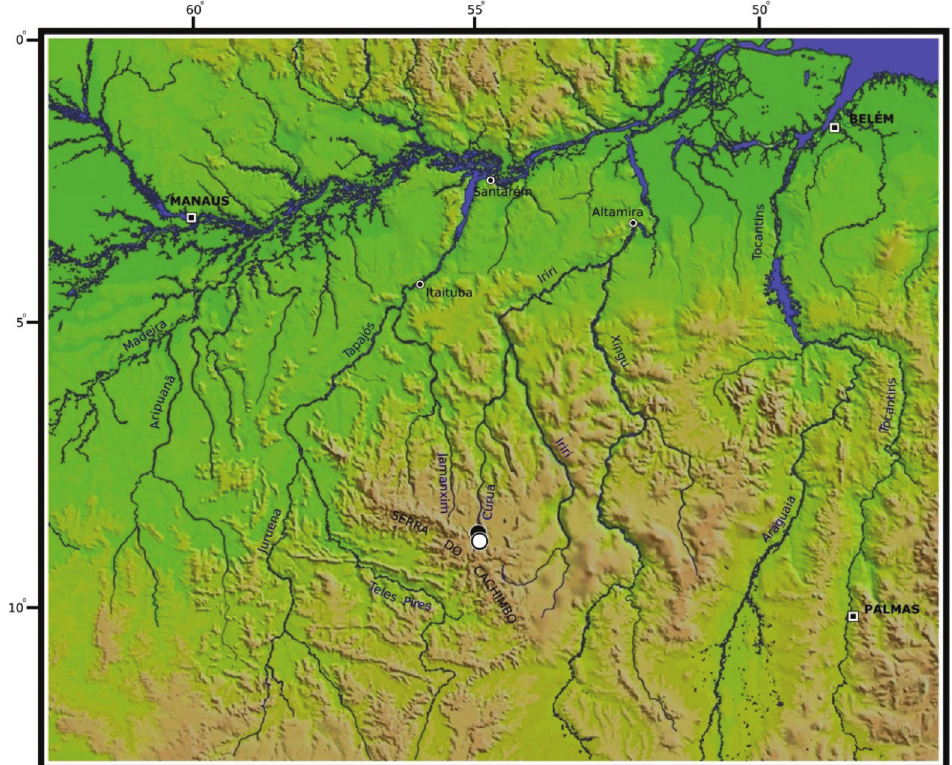
Fig. 4. Distribution of Jupiaba kurua in rio Curuá, Xingu basin, central Brazil (type locality represented by open